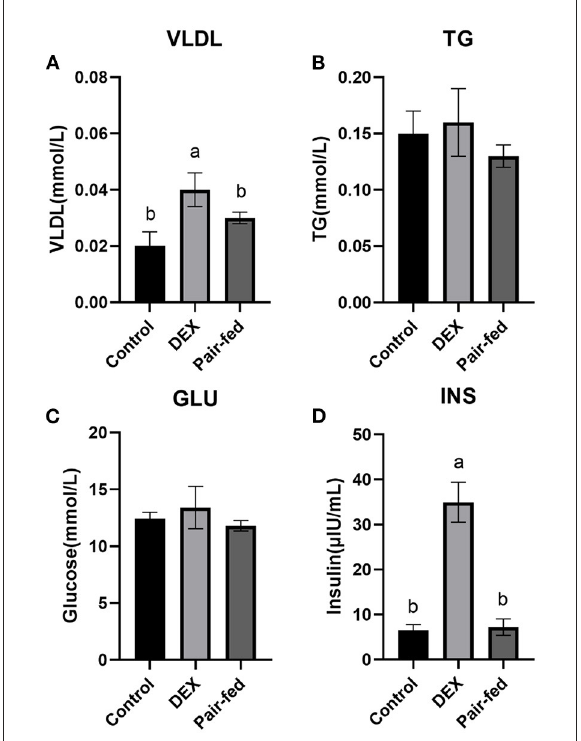
FIGURE1 Effects of dexamethasone on blood parameters of broilers. (A) VLDL concentration; (B) TG concentration; (C) GLU concentration; (D) INS concentration. Data are presented as the mean ± SEM ( n = 10). Different superscripts without common letters differ significantly ( P <